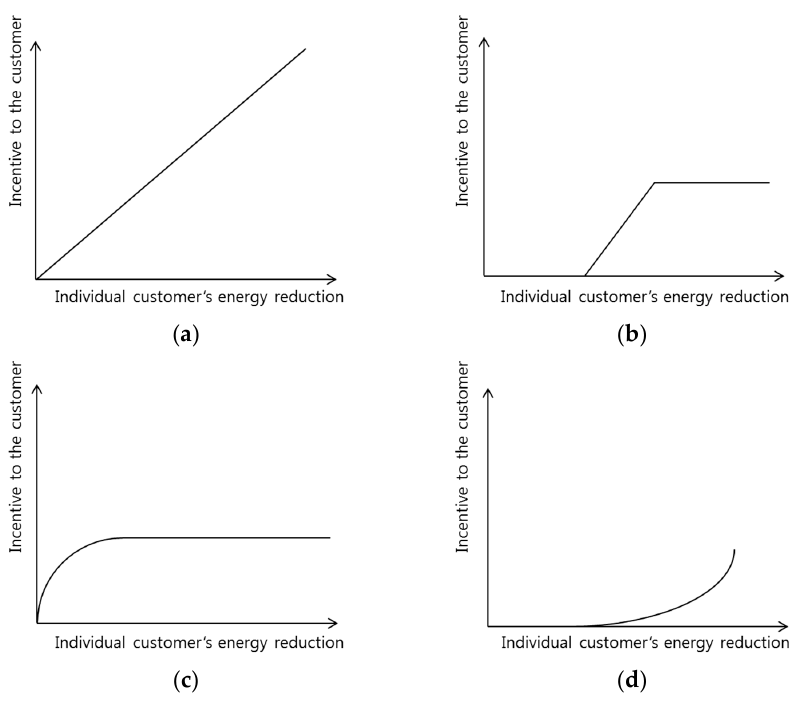
Figure 3. Example incentive functions for customers. Multiple scenarios are possible, such as: ( a ) linear; ( b ) guaranteed reduction and upper bound on incentive; ( c ) upper bound on incentive; and ( d ) quadratic incentive. Each customer may have a different incentive function, according to its individual contract.